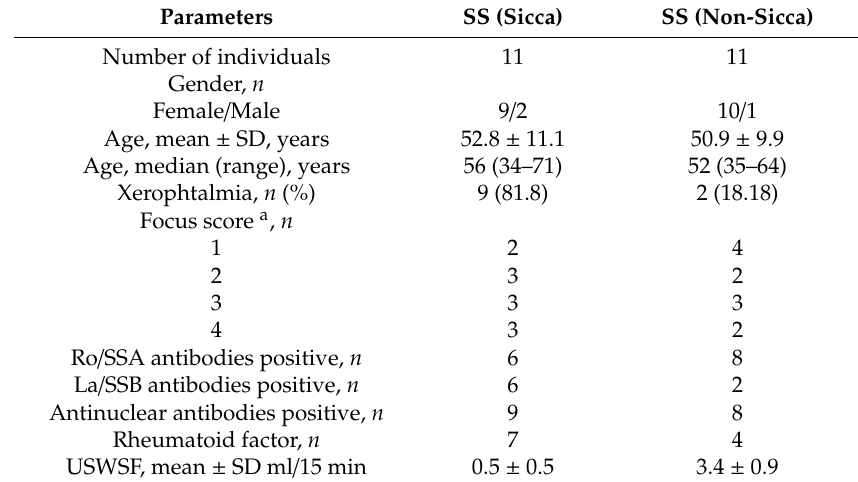
Table 4. Demographic, serological and histological characteristics of the SS (sicca) and SS (non − sicca) patients participating in the RT-qPCR